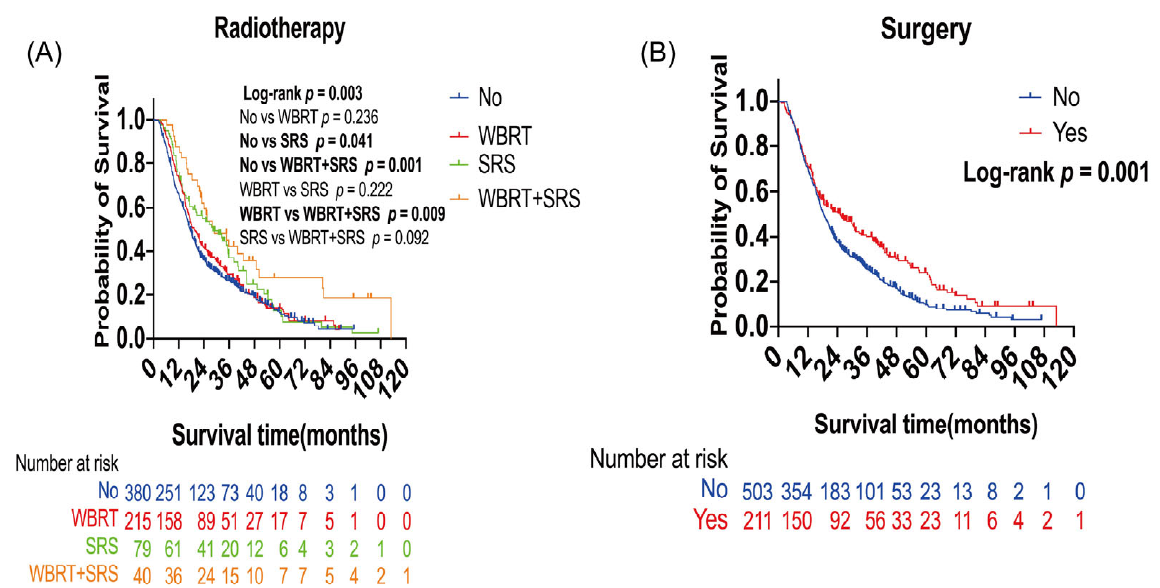
Figure 1. Kaplan–Meier overall survival (OS) curves of patients with lung cancer brain metastases: ( A ) Kaplan–Meier OS curves according to radiotherapy; ( B ) Kaplan–Meier OS curves according to surgery. Plot symbols at both events and censored cases. SRS, stereotactic radiosurgery; WBRT, whole brain radiotherapy. Table 1. Characteristics of patients with lung cancer BMs stratified by surgery or radiotherapy.